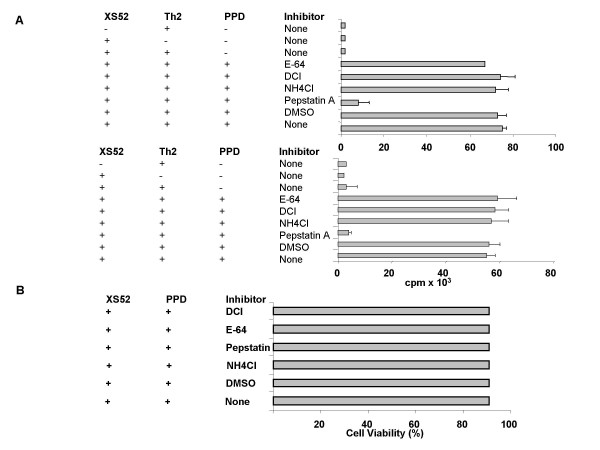
Pepstatin A inhibits the capacity of XS52 DC to present native PPD: (A) γ-irradiated XS52 DC were pulsed with PPD (100 μg/ml) in the presence or absence of each protease inhibitor (100 μg/ml pepstatin A, 100 μM DCI, or 100 μM E-64) or vehicle alone (1% DMSO or 15 mM NH4Cl). XS52 DC were then cultured for 2 days with the PPD-reactive Th1 or Th2 clone in the continuous presence of the same inhibitor or vehicle alone. Data shown are the mean ± SD (n = 3) of 3H-thymidine uptake in three representative experiments. (B) XS52 DC were incubated with each of protease inhibitor (100 μg/ml pepstatin A, 100 μM DCI, or 100 μM E-64) or vehicle alone (1% DMSO or 15 mM NH4Cl) for 16 hrs. Subsequently, cells were harvested and their viability was measured by trypan blue.